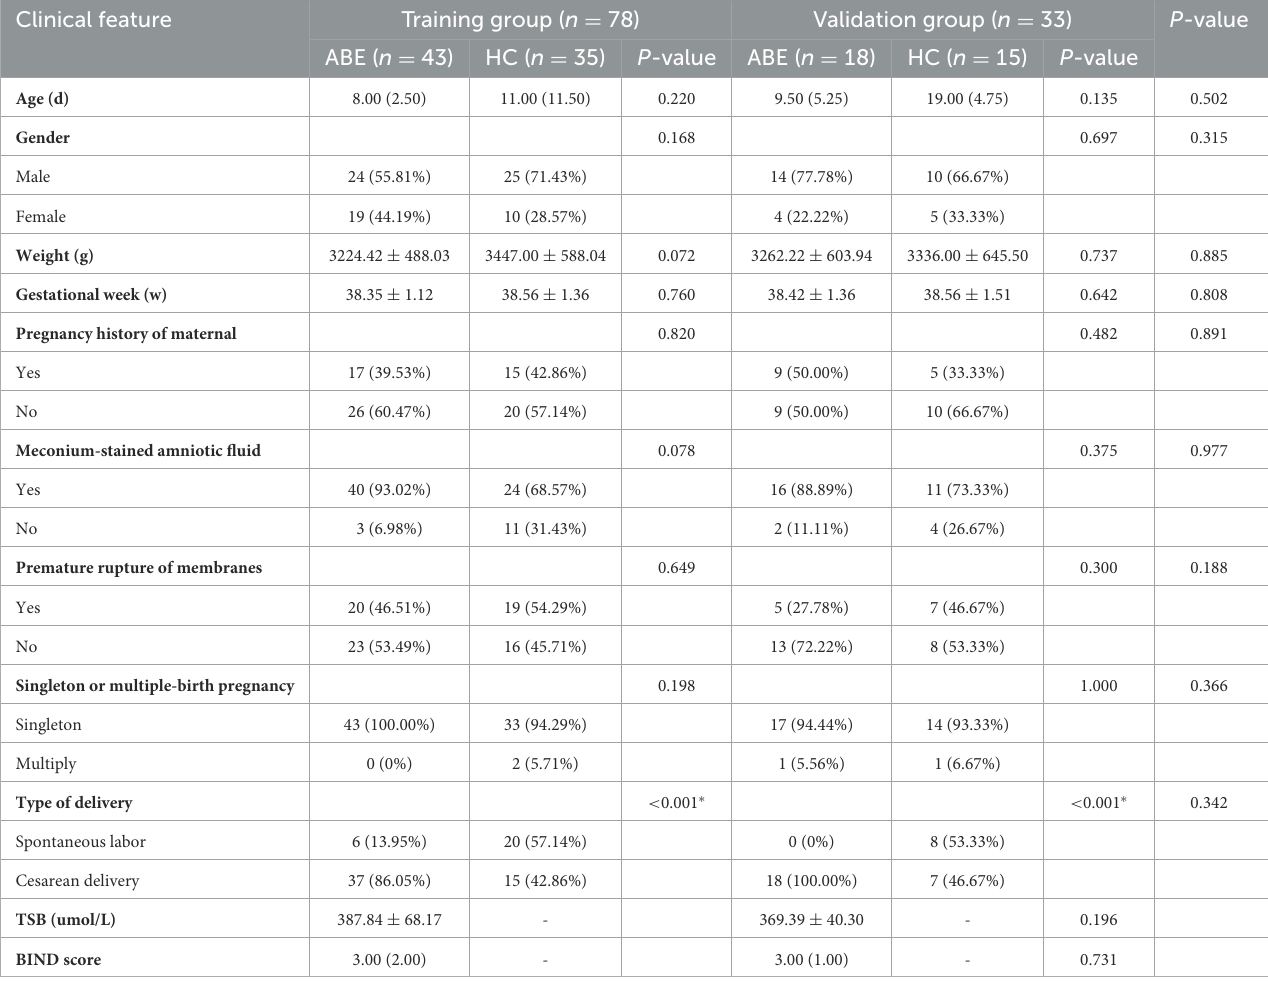
TABLE 1 Patient clinical features between the training and validation groups. Clinical